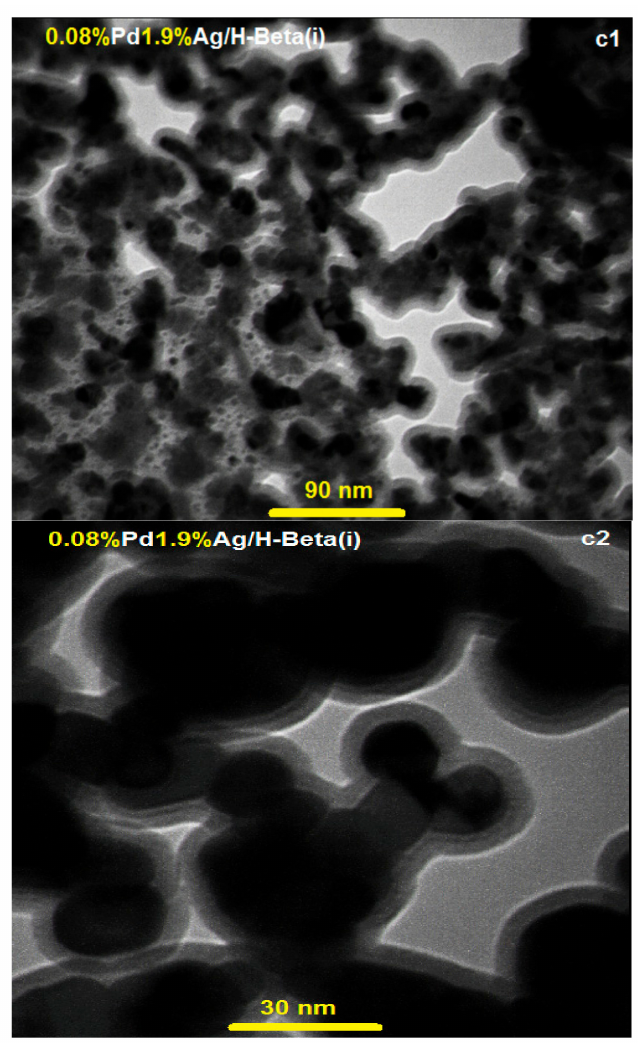
Figure 4. Transverse Electric and Magnetic Field (TEM) patterns of different Beta(i)-based catalysts, ( a1 , a2 ) 0.08%Pd0.29%Ir/H-Beta(i), ( b1 , b2 ) 0.08%Pd2.9%Ce/H-Beta(i), and ( c1 , c2 ) 0.08%Pd